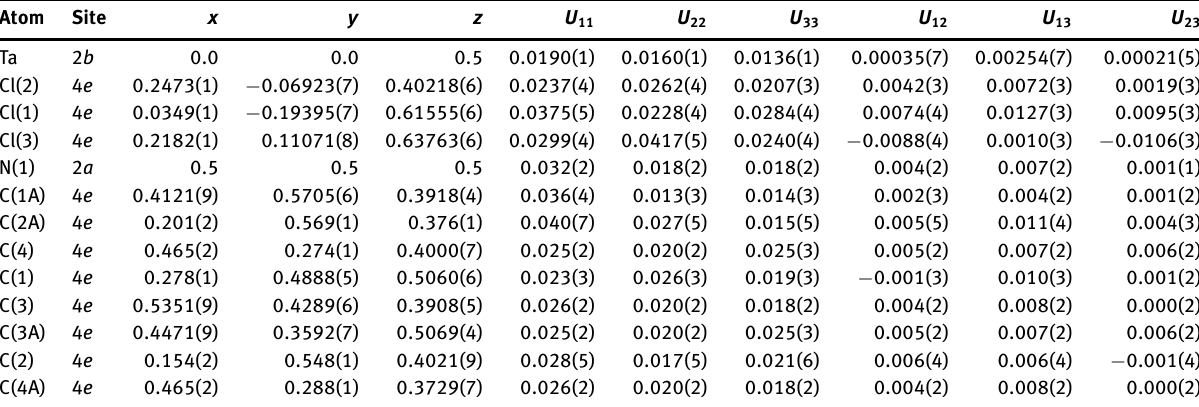
Table 3: Atomic displacement parameters (Å 2